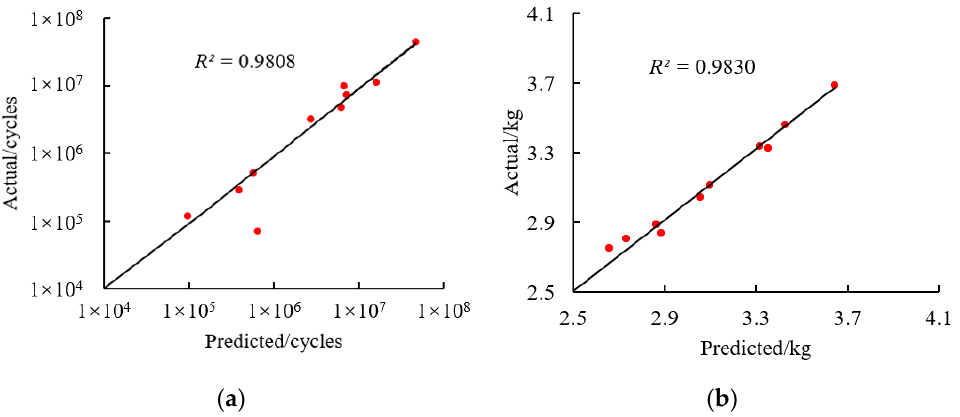
Figure 11. Accuracy verification of Kriging models. ( a ) Fatigue life; ( b ) mass.